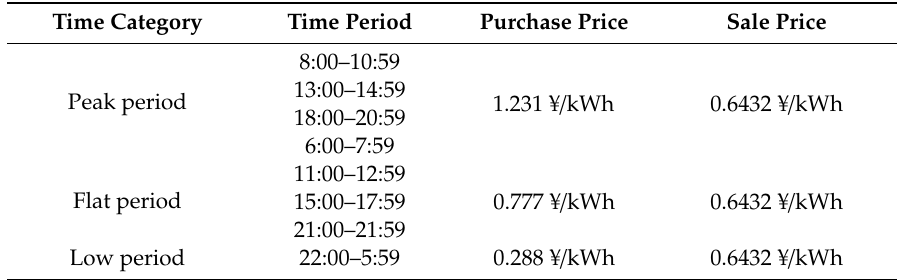
Table 1. Basic purchase and sale prices for the microgrid and large grid.